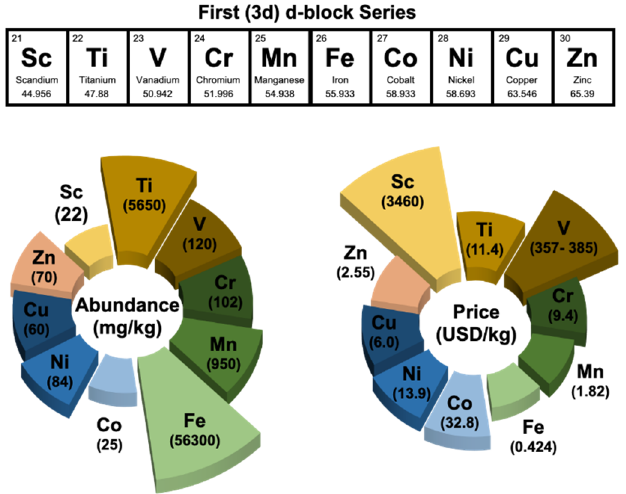
Scheme 1. Illustration of the various structures of perovskite oxides. ( a ) Primitive perovskite with an ideal cubic structure; ( b ) A-site ordered double perovskite oxide with a tetragonal structure; and ( c ) layered perovskite with a Ruddlesden–Popper structure (A n + 1 B n O 3n + 1, n = 1, 2, and 3);